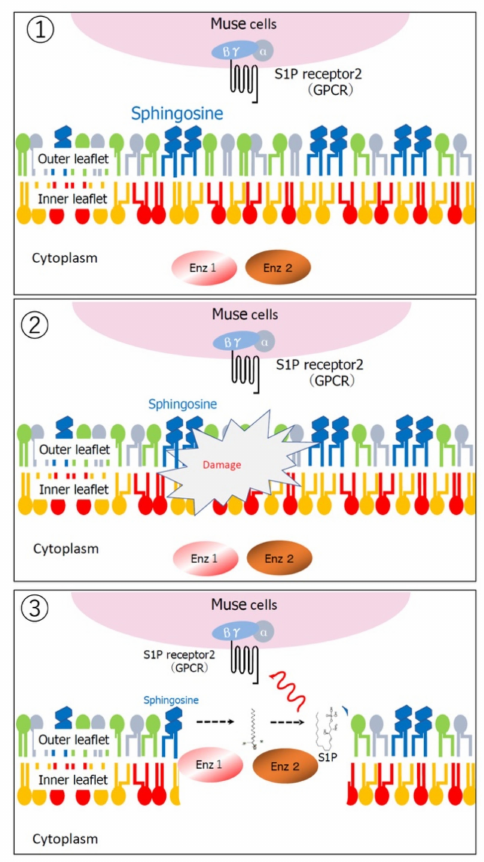
Figure 3. Production of sphingosine-1-phosphate by damaged cells. ( 1 ) Sphingosine, located in the outer leaflet of the cell membrane, is the substrate of sphingosine-1-phosphate (S1P). ( 2 ) When the cell membrane is damaged, ( 3 ) sphingosine reacts with enzymes (Enz1, Enz2) and is phosphorylated to become S1P. Released S1P binds to S1P receptor 2, a G-protein coupled receptor, on Muse cells to attract them to the site of damage. This figure was reproduced with permission from Advances in Experimental Medicine and Biology (Springer, copyright 2018